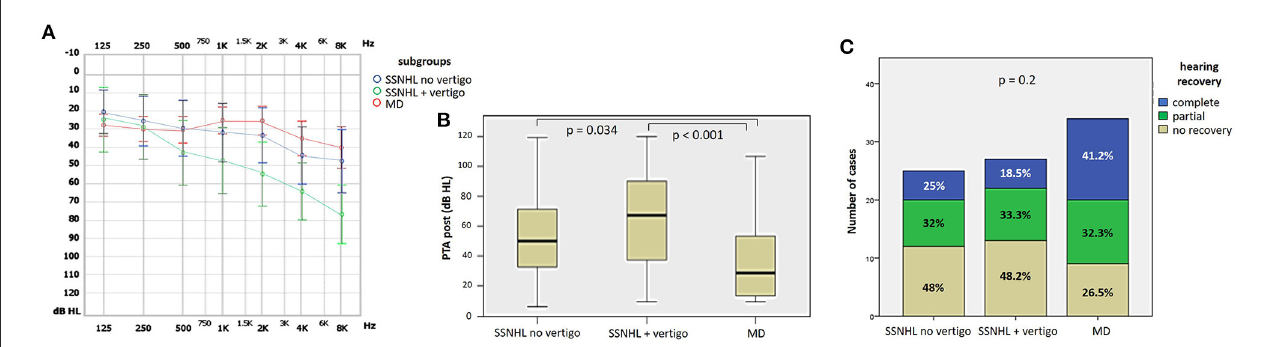
FIGURE7 Final audiometric features at 6-month follow up of the affected ear of the overall cohort, divided in subgroups based on clinical course. (A) Audiogram. (B) Box plot correlating median values of PTA among subgroups. Statistically significant differences at the ANOVA test are shown. (C) Bar plot showing the different distribution of hearing recovery among different subgroups. Relative percentages are reported in each column and p -value of categorical comparisons is reported. MD, Menière’s disease; PTA post, pure tone average at 6-month follow up; SSNHL, sudden sensorineural hearing loss.